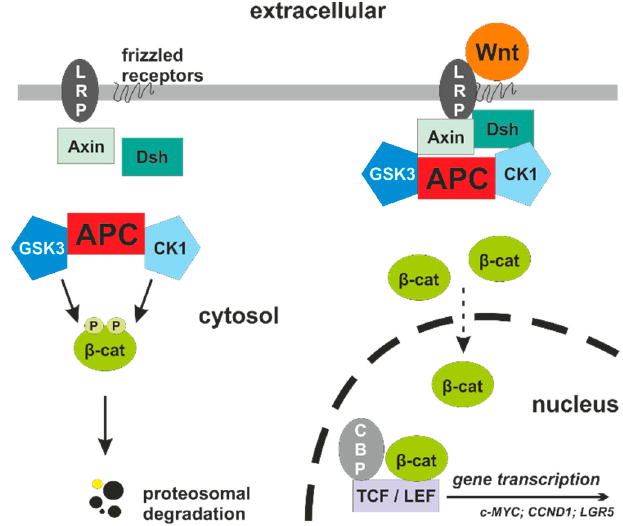
Figure 1. Canonical Wnt signaling pathway. Left: In the absence of Wnt ligands, the multi-protein complex with APC, GSK3, and CK1 cause phosphorylation and subsequent proteosomal degradation of β -catenin. Right: Upon binding of a Wnt protein ligand, the phosphorylation activity of the protein complex is inhibited and β -catenin accumulates in the cytoplasm and translocates to the nucleus with activation of gene transcription. APC: adenomatous polyposis coli; β -cat: β -catenin; CBP: cAMP-response element-binding protein; CK1: casein kinase 1; Dsh: Disheveled; GSK3: glycogen synthase kinase 3; LRP: low-density lipoprotein-related protein.